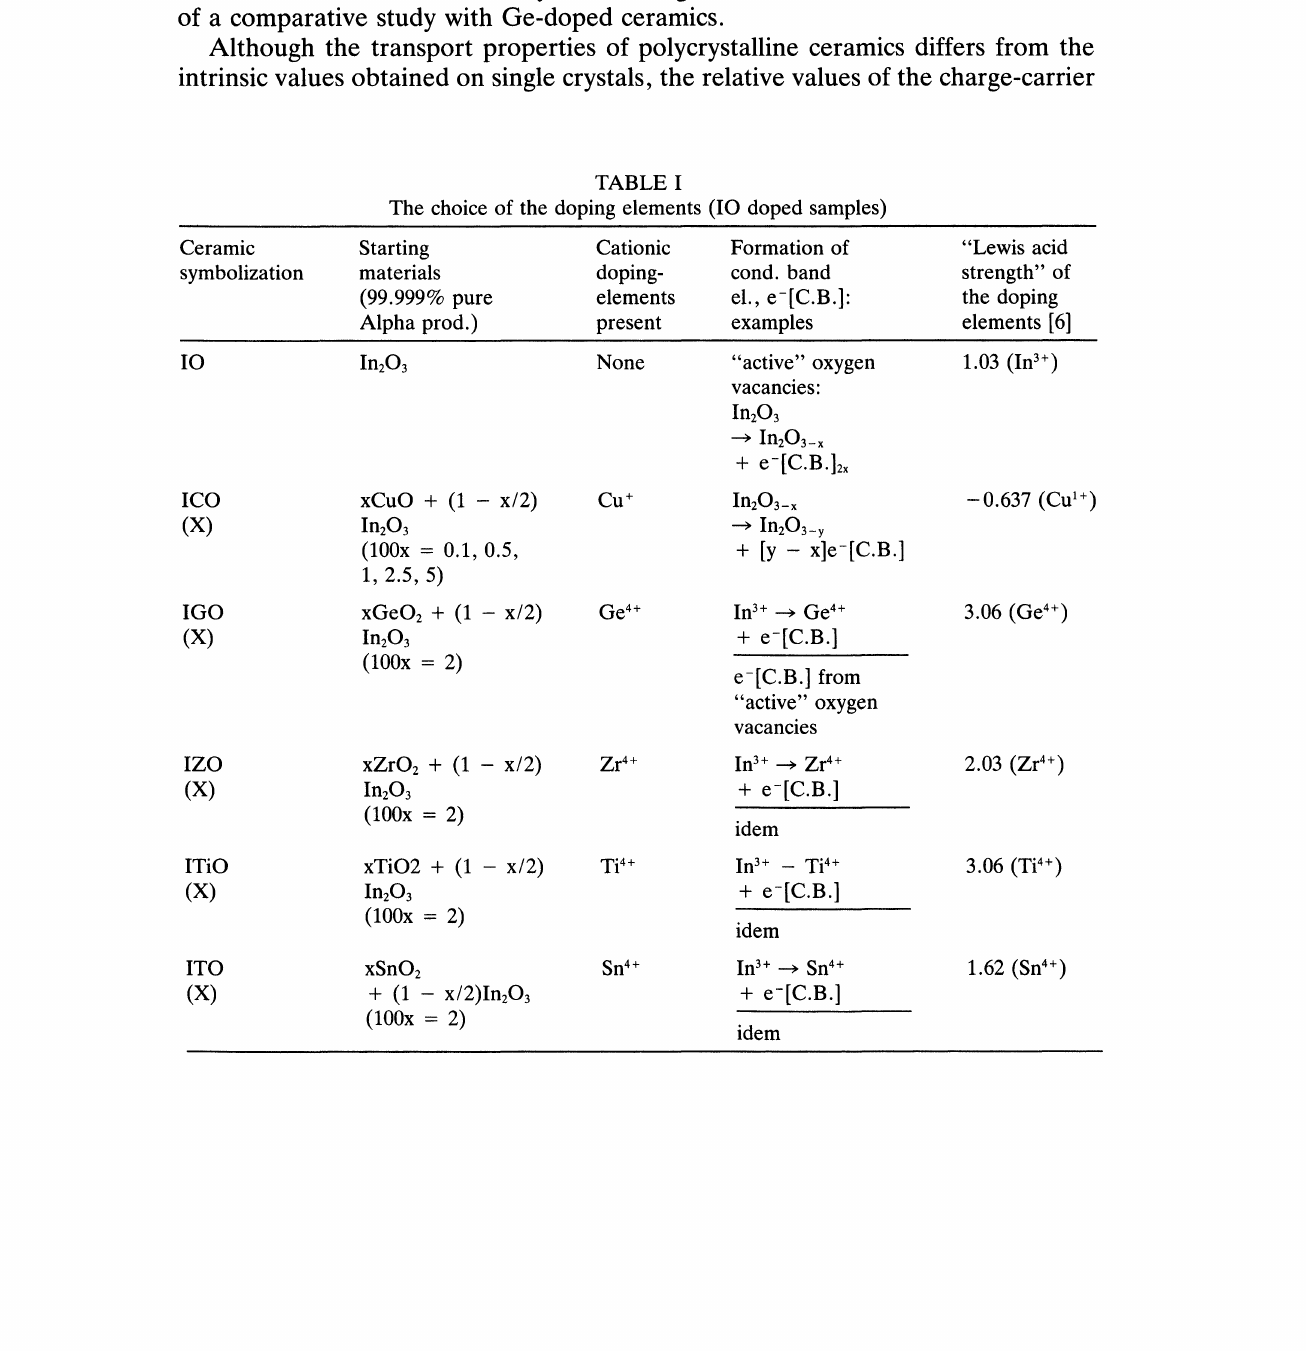
The choice of the doping elements (IO doped